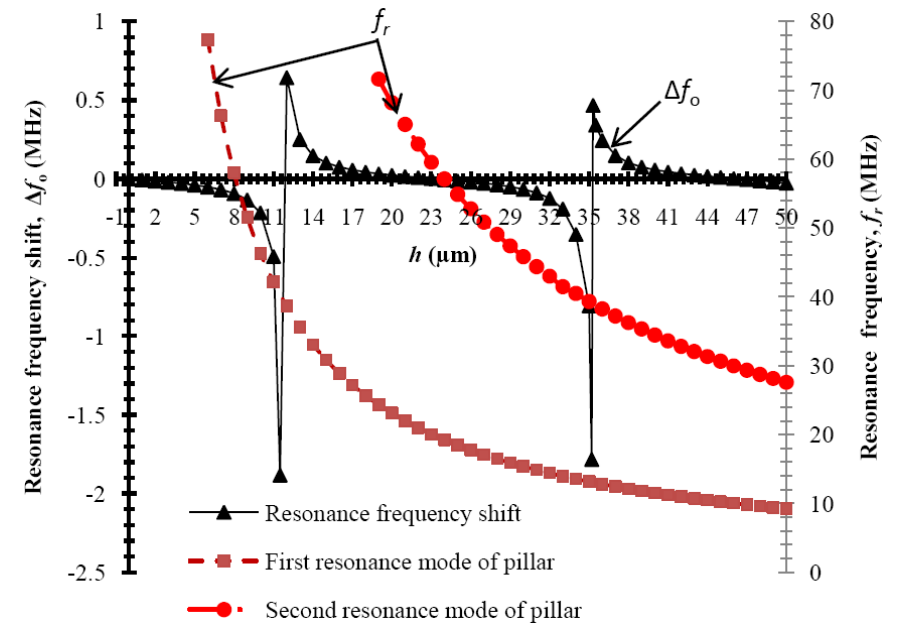
Figure 2. Plot of simulated results: Height of pillar versus resonance frequency shift, and resonance frequency of the pillar. The width of the pillar considered is 8.3 µm. Note that the resonance frequency of the SAW resonator is 39